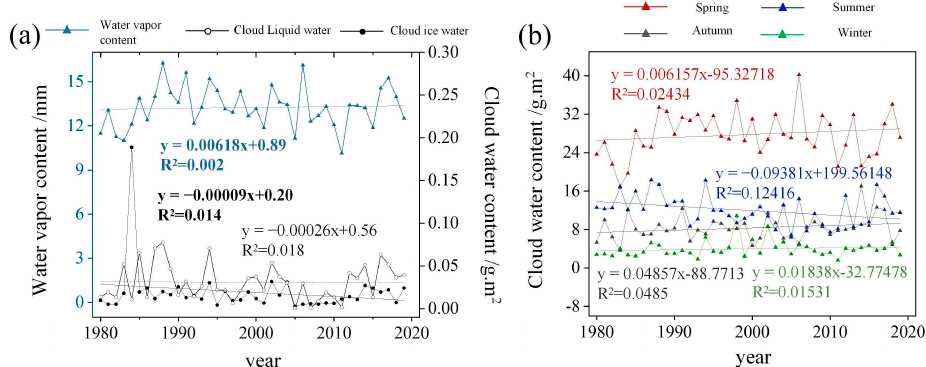
Figure 4. ( a ) Annual average temporal changes in water vapor content, cloud ice water, and cloud liquid water in the Yellow River Basin for 1980–2019; ( b ) seasonal mean time change in water vapor content in the Yellow River Basin from 1980 to 2019.